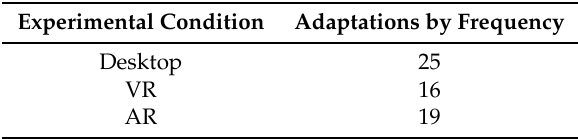
Table 3. Total Count of Required Adaptations per Experimental